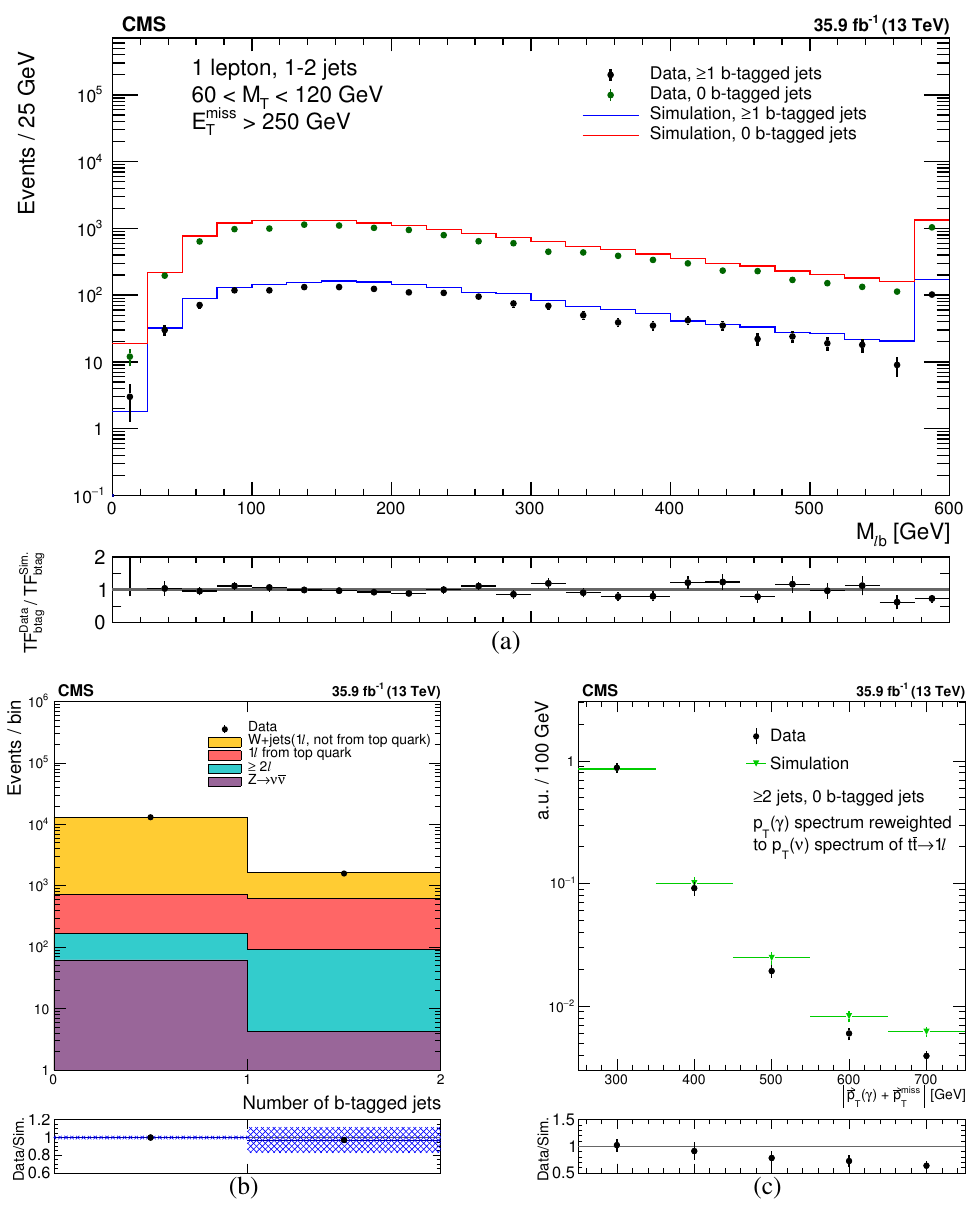
Figure 3 . Comparison of the modeling of kinematic distributions in data and simulation relevant for the estimate of the single lepton backgrounds. (a) Distribution in M ‘ b in a control sample with 1 or 2 jets, with 60 < M T < 120 GeV and E miss > 250 GeV. The distribution is shown separately T for events with 0 and (cid:21) 1 jet passing the requirement of the medium b tagging WP. The lower panel shows the ratio of the transfer factors (TF) from the 0 b-tagged jets to the (cid:21) 1 b-tagged jets samples, in data and simulation. The uncertainty shown is statistical only. (b) Distribution in the number of b-tagged jets in the same control sample. The shaded band shows the uncertainty resulting from a 50% systematic uncertainty in the heavy (cid:13)avor component of the W+jets sample. (c) Comparison of the E miss distribution between data and simulation in the (cid:13) +jets control region. T The uncertainty shown is statistical only. The ratio between data and simulation shown on the lower panel is used to correct the simulation for its E miss resolution. T